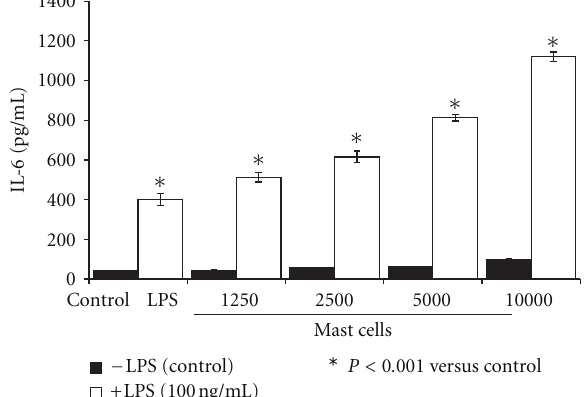
Figure 2: Mast cells dose-dependently potentiate LPS-induced IL- 6 production by HCAEC. Endothelial cells (10,000 cells/well) were grown for 24h in the presence of increasing number of HMC-1 5C6 cells and were activated with LPS (100 ng/mL) for a period of 24 h. After the incubation, culture supernatants were analyzed for IL-6 by ELISA. Results are mean ± SEM of quadruplicate determinations of a representative experiment. Similar results were observed in two other